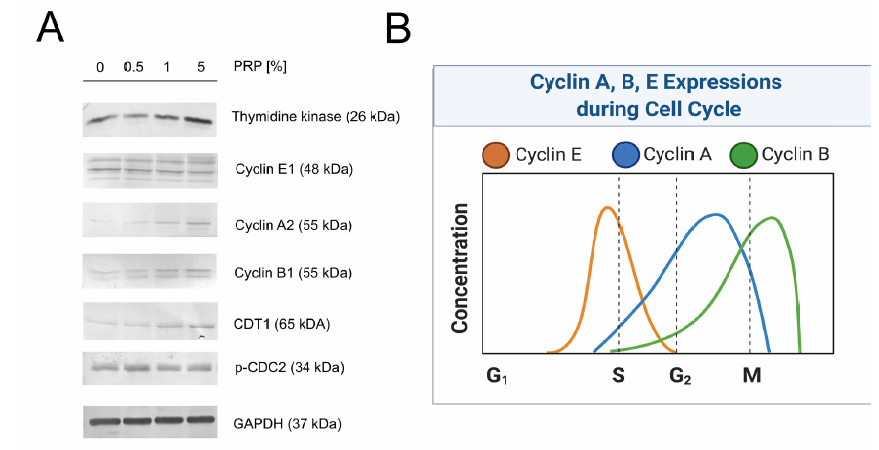
Figure 1. Platelet-rich plasma (PRP)-dependent stimulation of DNA biosynthesis and cell migration of human keratinocytes (HaCaT). ( A ) HaCaT cell proliferation after 24 and 48h incubation with PRP; ( B ) HaCaT cell migration in a model of wound healing/scratch assay; ( C ) wound healing rate of HaCaT cells. Statistical significances were expressed using asterisks such as, ** <0.01, and **** <0.0001.